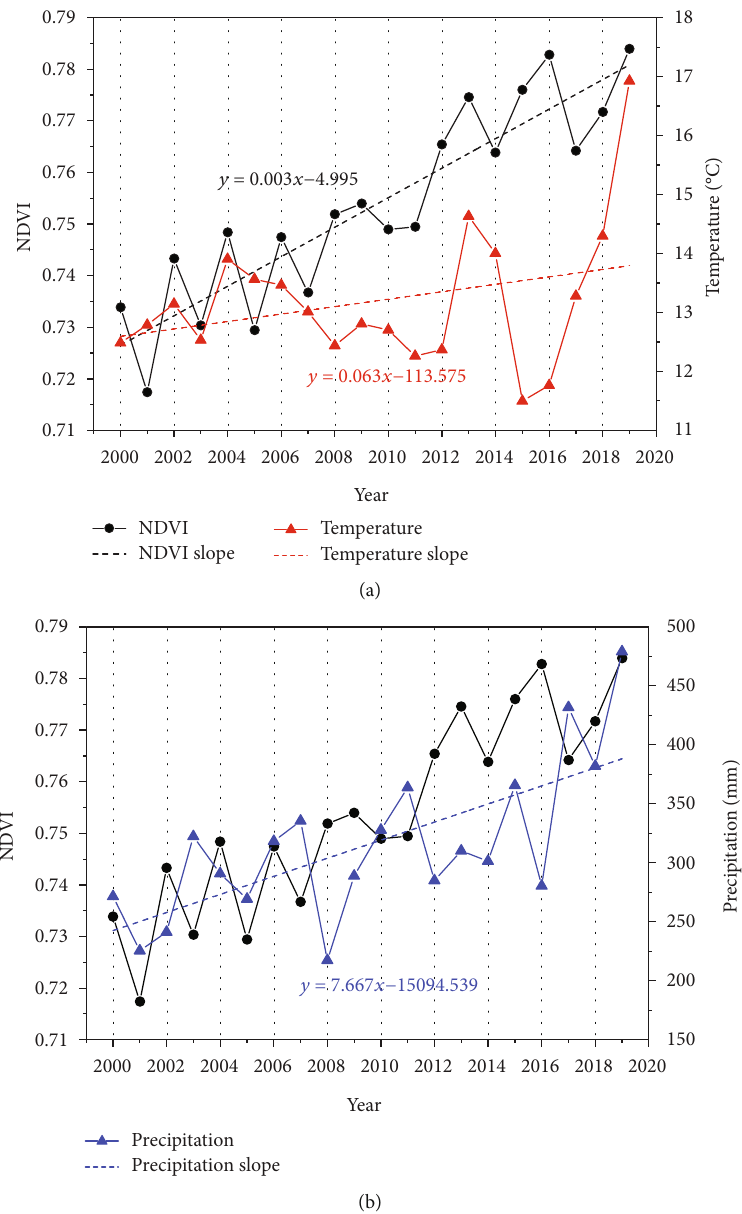
Figure 7: Variation curves of the mean annual temperature, precipitation, and vegetation NDVI during the growing seasons: (a) temperature, and (b)